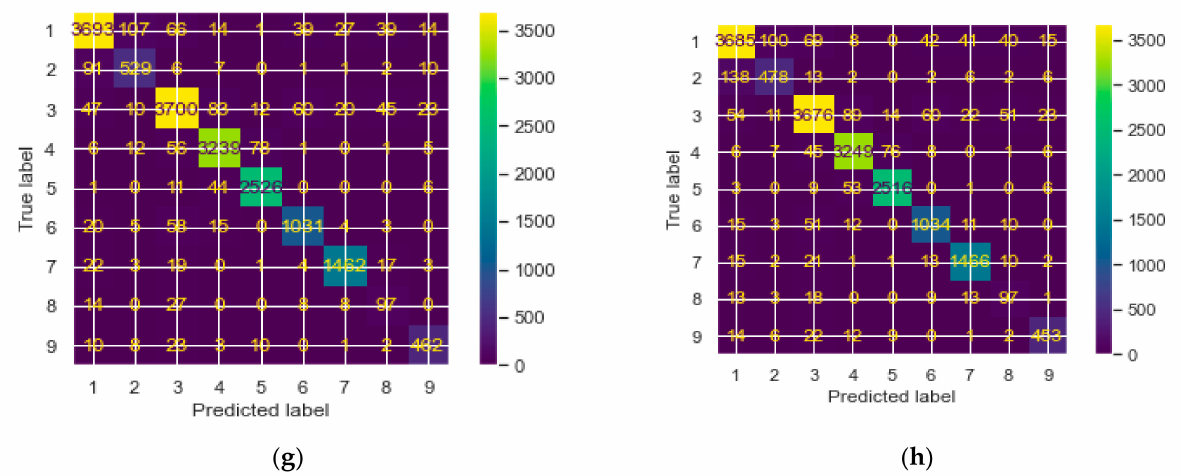
Figure 6. Confusion matrix depicting the correctly and falsely predicted LCC for Reunion Island for all the deep learning models: ( a ) bidirectional GRU; ( b ) temporal CNN; ( c ) GRU + temporal CNN; ( d ) attention on temporal CNN; ( e ) attention on temporal CNN + GRU; ( f ) univariate + multivariate + coordinates; ( g ) univariate + multivariate; and ( h ) univariate + multivariate (LSTM) + coordinates.